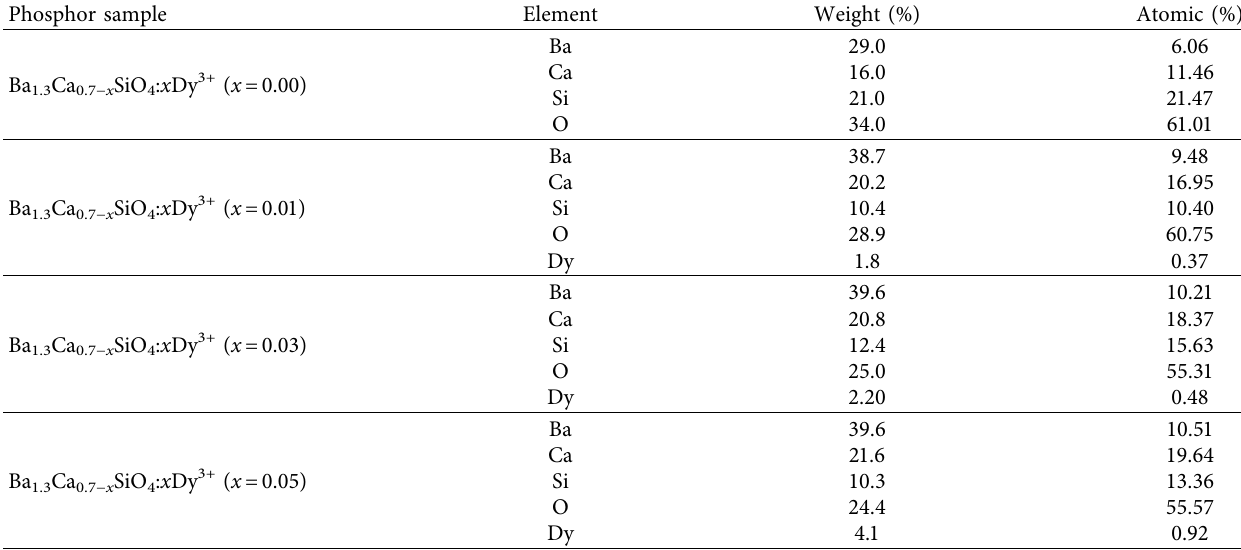
Table 2: The weight and atomic percentage of Ba 3+ samples as a function of Dy 3+ doping concentration ( x � 0.00, 0.01, 1.3 Ca 0.7 − x SiO 4 : x Dy 0.03, and 0.05) based on the energy-dispersive X-ray spectroscopy (EDS) analysis. Phosphor sample Element Weight (%) Atomic (%)